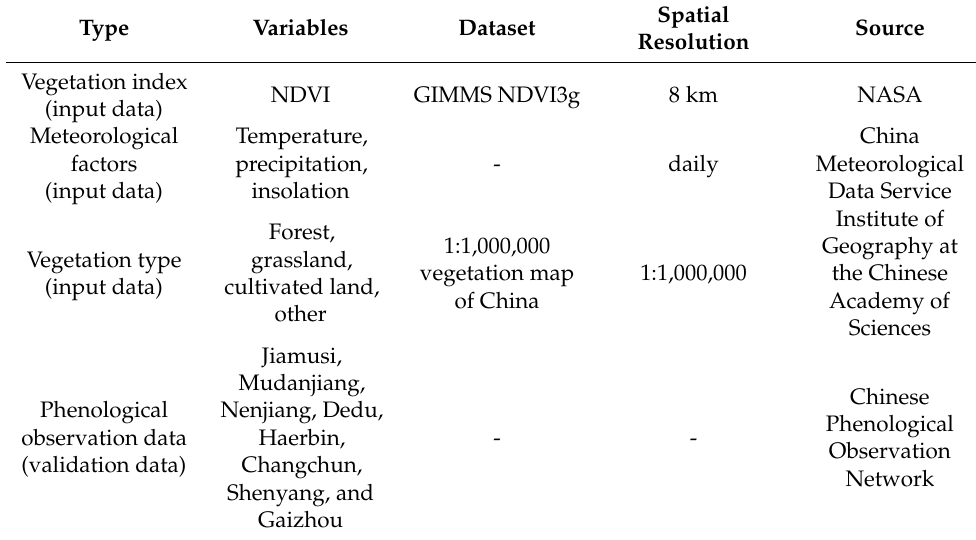
Table 1. Determination of Phenological